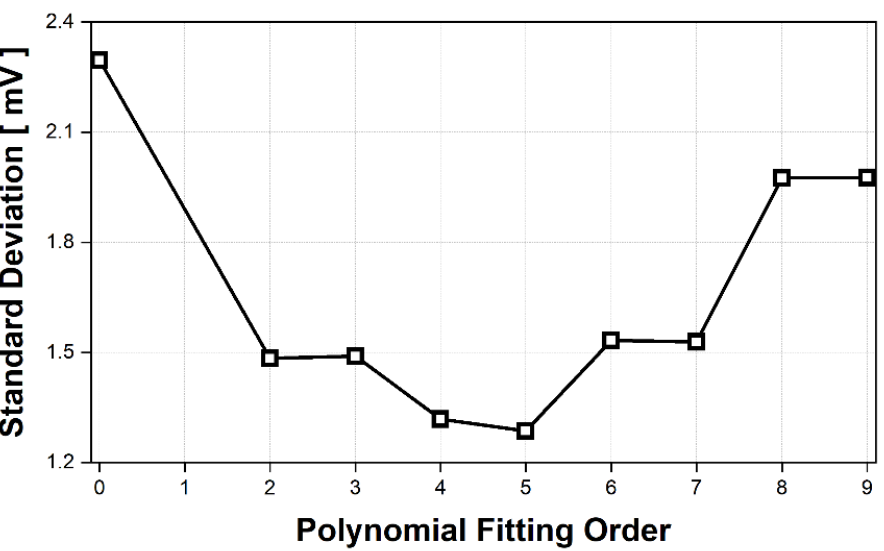
Figure 11. Standard deviation for the radius of the generated circle trajectory in the I/Q plots shown in Figure 10.